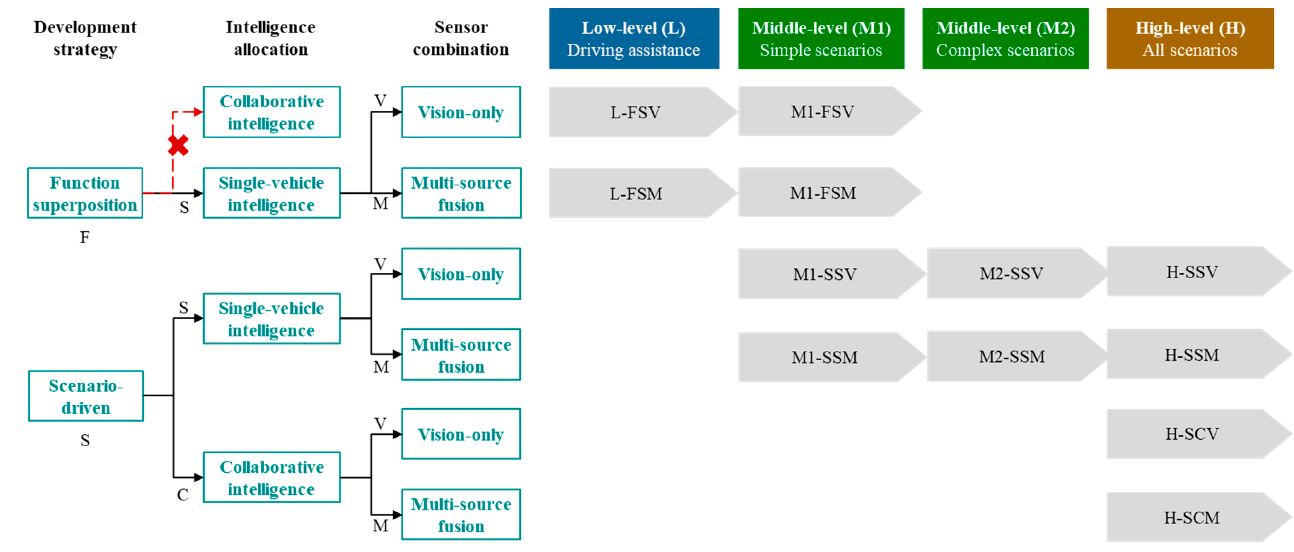
Figure 1. Main technical routes of intelligent driving at different levels.